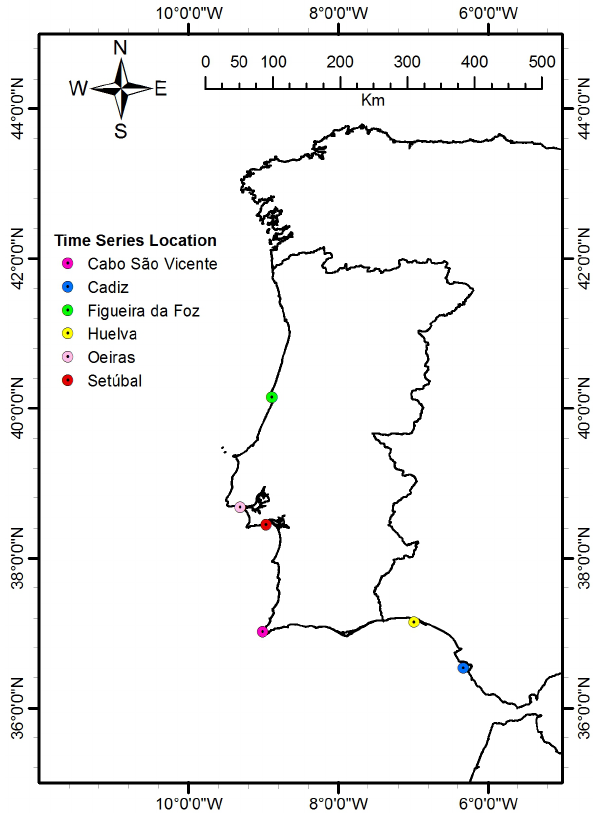
Fig. 3. Time series location points for the Portuguese